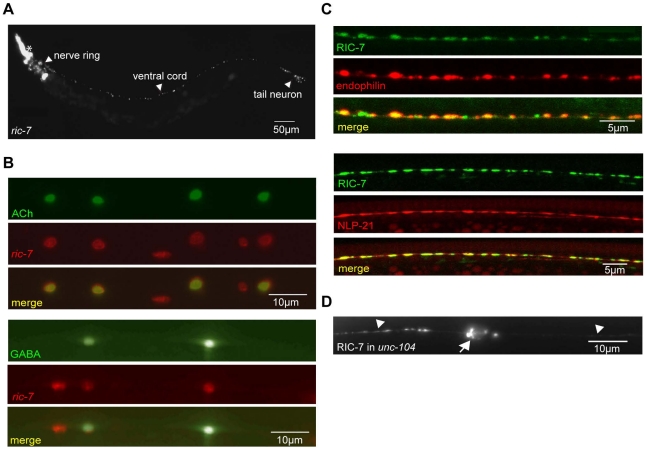
Expression pattern of RIC-7.(A) The ric-7 promoter expresses nuclear localized Cherry (HIS-24::wCherry) primarily in the nervous system of an adult worm. Anterior is left; ventral is up. The asterisk indicates fluorescence encoded by a co-injection marker. (B) The ric-7 promoter is expressed in cholinergic (top panel) and GABAergic (bottom panel) motor neurons in the ventral cord. Cell bodies of cholinergic (unc-17 promoter) and GABAergic (unc-30 promoter) neurons were identified by expression of the indicated GFP reporter constructs. (C) Distribution of RIC-7, a synaptic vesicle marker (UNC-57 Endophilin) (top panel), and a DCV marker (NLP-21) (bottom panel) are compared in the dorsal cord axons of cholinergic motor neurons. (D) Distribution of RIC-7::GFP in cholinergic motor neurons of unc-104 KIF1A mutants. Cell bodies (arrow) and ventral cord processes (arrow heads) are indicated.